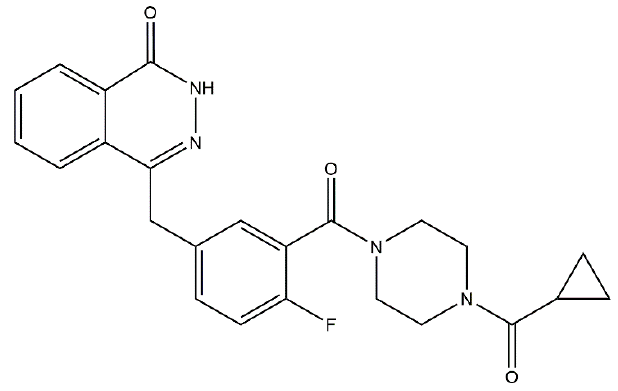
Figure 1. Chemical structure of olaparib.